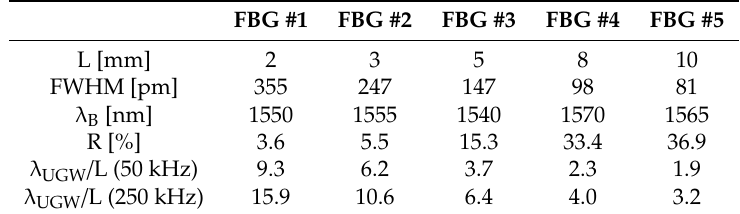
Table 1. Overview of FBG sensors and their properties. FWHM: full width at half